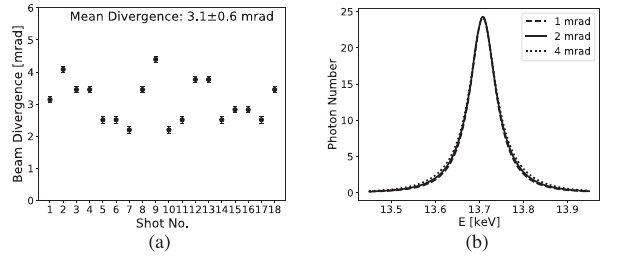
FIG. 4. (a) Shot-to-shot variations of beam divergence. (b) Si- mulated PXR line for different beam divergences of interest (bunch charge 40 pC).